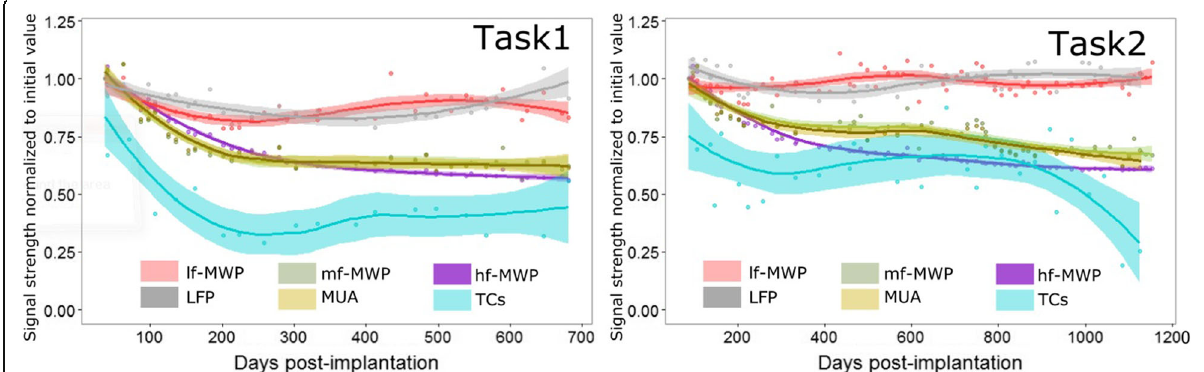
Fig. 5 Signal stability presented by the normalized signal strength. Within each time series, the data is normalized to its initial value. In Task 1, the normalized signals strength for mf -MWP, hf -MWP, MUA and TCs were stabilized after approximately 300 days of decline, while normalized signal strength for lf -MWP and LFP showed a better signal stability over time. MUA and mf-MWP signals shared a very similar profile in signal declining with most of their confidence interval ranges overlap with each other. In a longer study in Task 2, similar signal stability was observed overall,